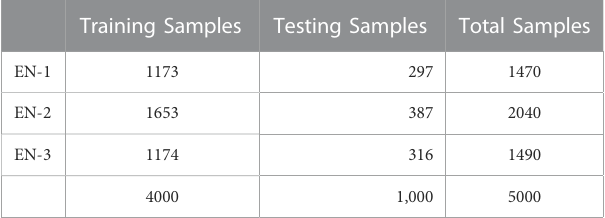
TABLE 1 ViWi dataset samples distribution for VFWN model training. To evaluate the performance of the global model, a global testset of 1,000 data samples is used, which is never used in the training process. The dataset is almost balanced for both LOS and N-LOS scenarios. Training Samples